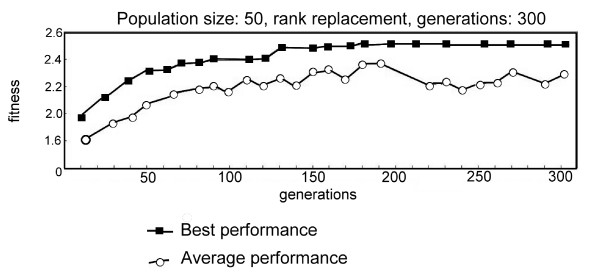
Fitness of organisms over 300 generations. We show the evolutionary progress of a population in REGAL. Each organism in the population represents a classifier for scoring edited and unedited cytosine nucleotides, and the fitness of any organism is given by the average score of the edited cytosines divided by the average score of the unedited cytosines. The line with circles represents the average performance of organisms within the simulation, and the line with black boxes represents the performance of the most fit organism within the simulation.